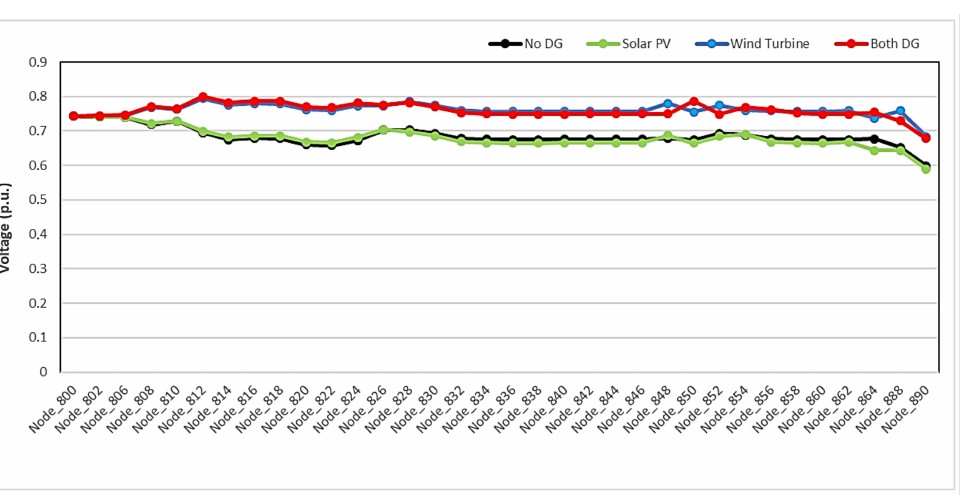
Figure 2. Active Distribution system voltage